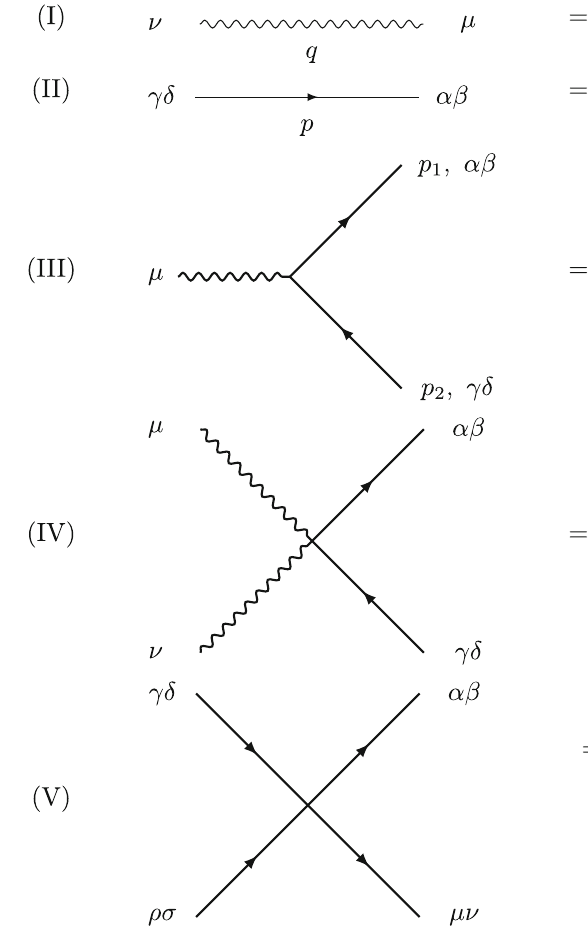
Fig. 1 Feynman rules of the